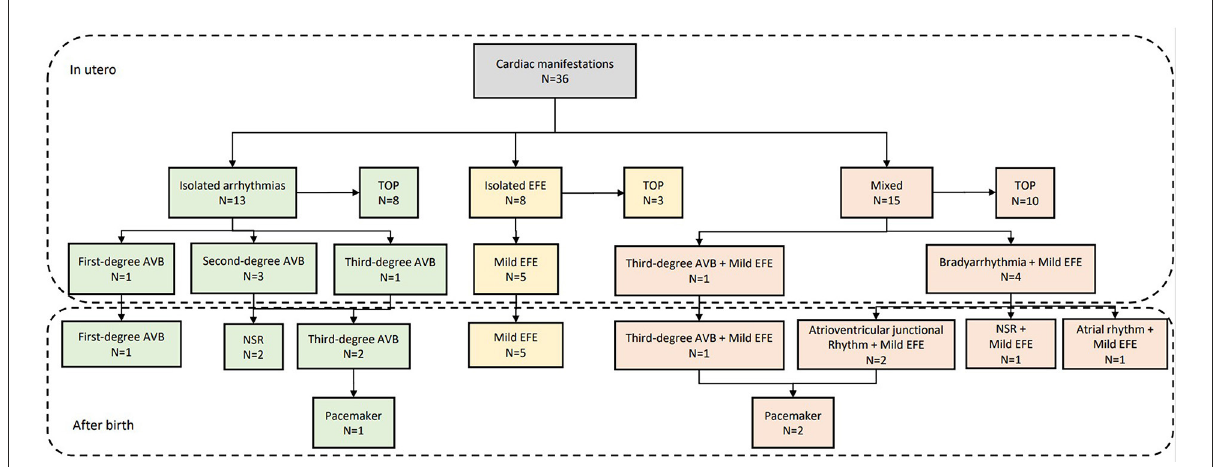
FIGURE4 Outcome of fetuses with cardiac manifestations due to maternal anti-Ro and anti-La antibodies. TOP, termination of pregnancy; EFE, endocardial fibroelastosis; AVB, atrioventricular block; NSR, normal sinus rhythm.